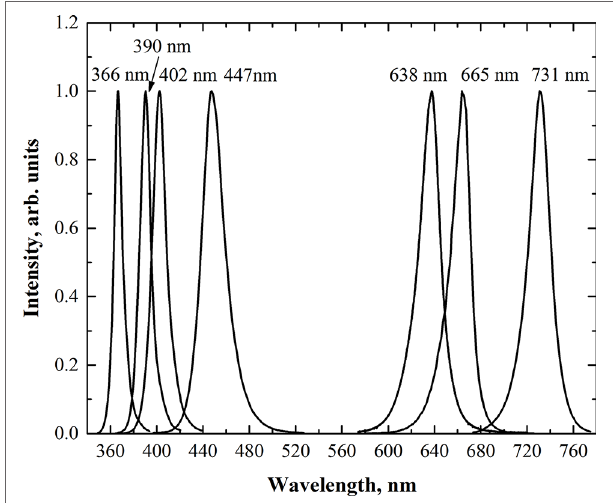
FIGURE 1 | Relative spectral distribution of the LEDs used in the lighting